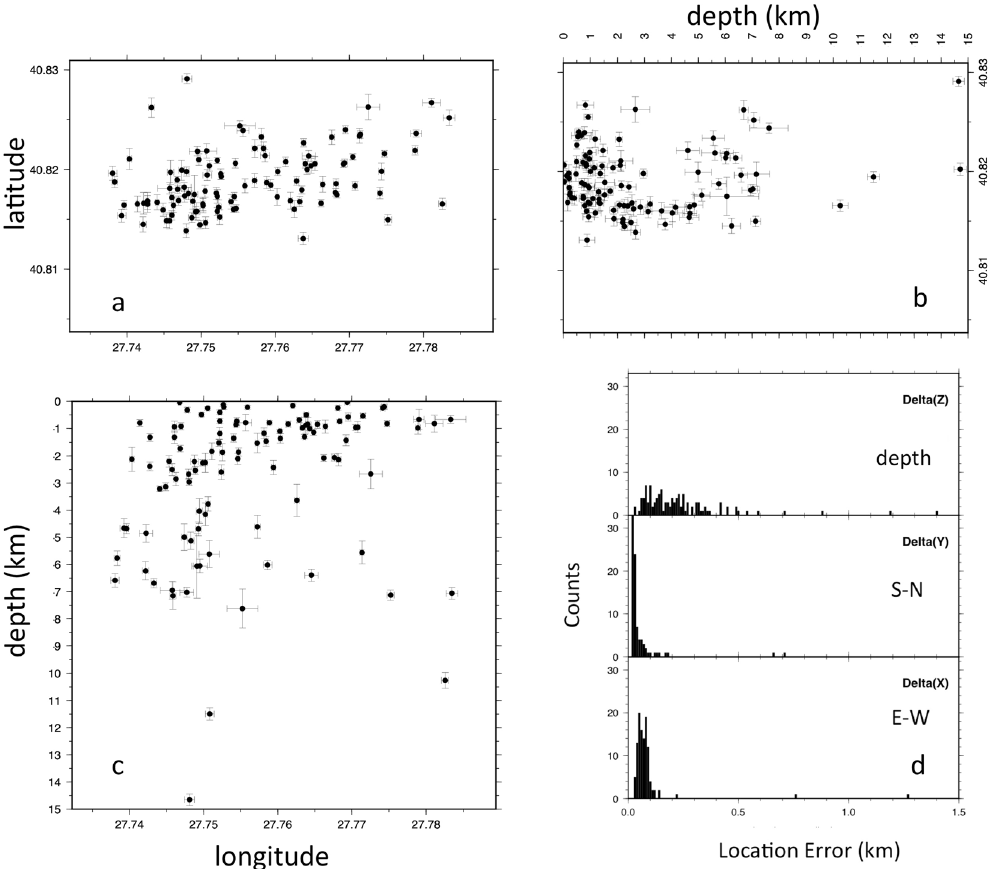
Figure 3. Location errors of the aftershocks shown in Fig. 2. ( a ) latitude-longitude plane; ( b ) longitude-depth plane; ( c ) latitude-depth plane. Panel d) displays the distribution of location errors in the 3 directions: depth (deltaz); South-North (delta (y)); Est-West (delta(x)). Image created with GMT software, Version